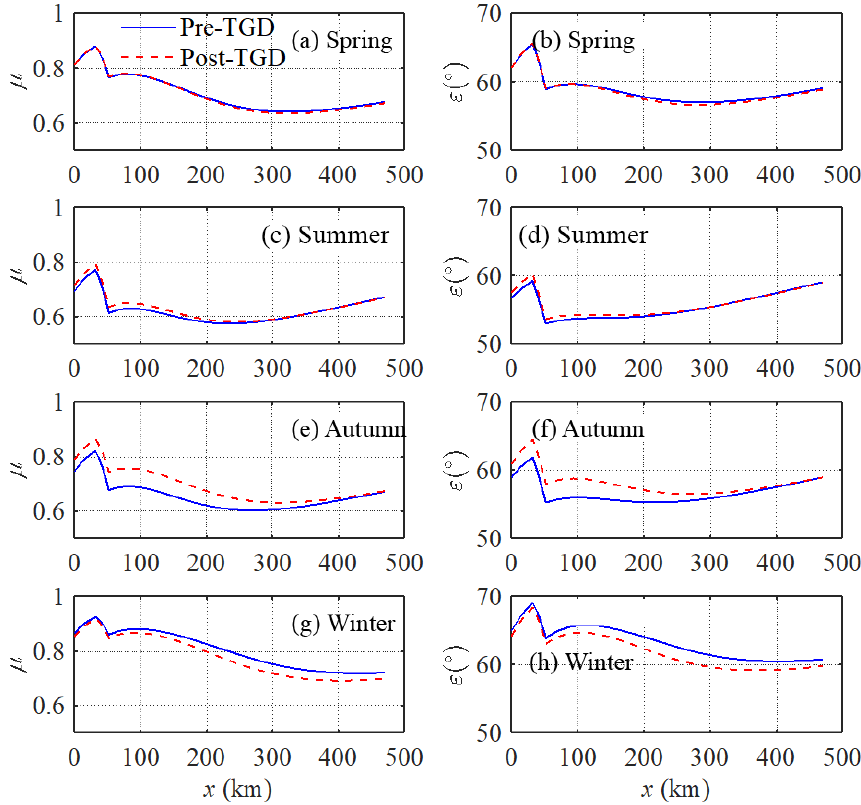
Figure 7. Longitudinal variability of simulated velocity number µ (a, c, e, g) and phase lag ε (b, d, g, i) along the Yangtze estuary in different seasons (spring: a, b ; summer: c, d ; autumn: e, g ; winter: g, i ) for both the pre-TGD and post-TGD